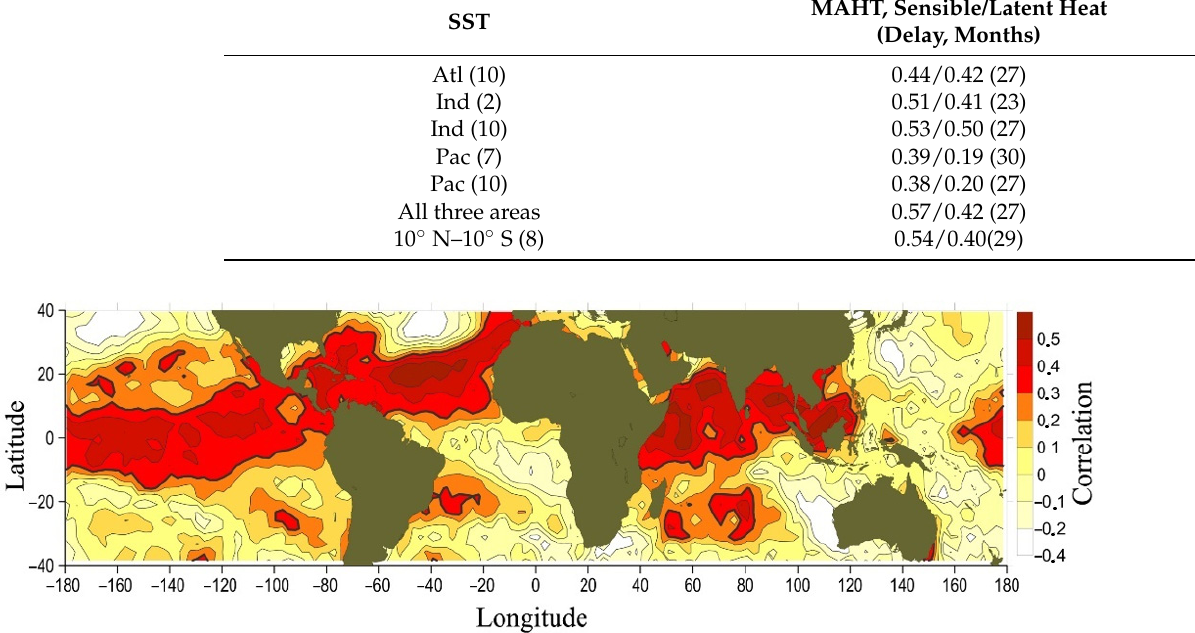
Figure 1. Patterns of correlation between SST in 40 ◦ S–40 ◦ N area in October and meridional atmospheric transport of sensible heat in December–February through 0–80 ◦ E at 70 ◦ N with 27 months lag. Thick line—coefficient correlation equal 0.30 (90% significance